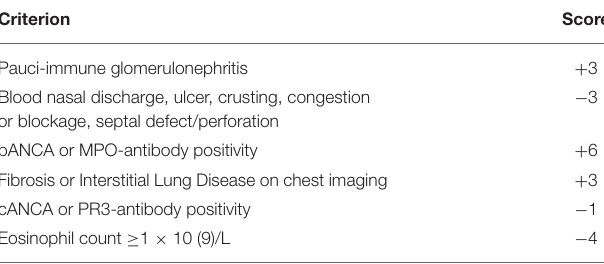
FIGURE 8 | Membranous Nephropathy. (A) LM shows (PAS stain) regular and diffuse thickening of GBM without endothelium-mesangial proliferation and (silver stain) the GBM matrix reaction due to the presence of deposits (spikes). (B) EM shows sub-epithelial deposits with spikes of GBM that begin to encircle the deposits (Stage 1). (C) IF: diffuse and granular subepithelial deposits of IgG along the capillary wall (garland pattern). TABLE 6 | According to EULAR/PRINTO/PReS criteria, the definition of GPA requires three out of six criteria (Sensitivity 93%, Specificity 99%). Criterion